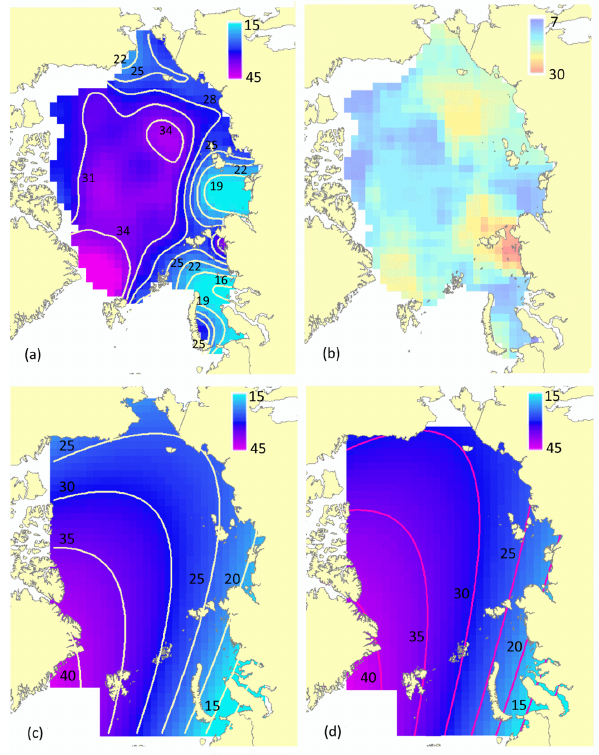
Figure 11. Map of snow cover depth (in cm) on the sea ice in the MAM months in 1959–1988: (a) gridded data with the grid cell 100x100 km and contour lines overlaid on it, (b) standard deviation of the data used for gridding, (c) map produced from the same data as (a) , but using two-dimensional quadratic fit shown by Eq. (3), (d) Warren climatology averaged for the MAM months.